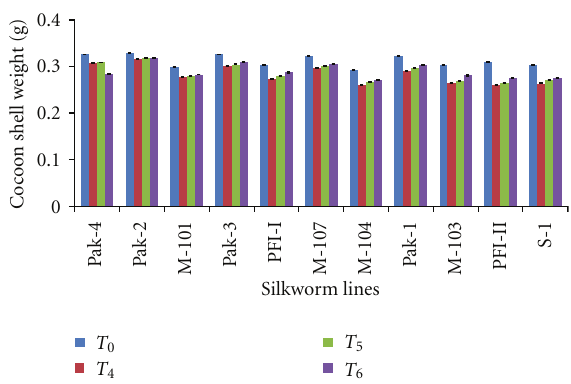
Figure 6: Comparative performance of cocoon shell weight (mean ± SE) of eleven silkworm lines at 25 ± 1 ◦ C in combination with 55, 65, and 75% RH and controlled conditions of temperature and RH (25 ± 1 ◦ C and 70–80%,